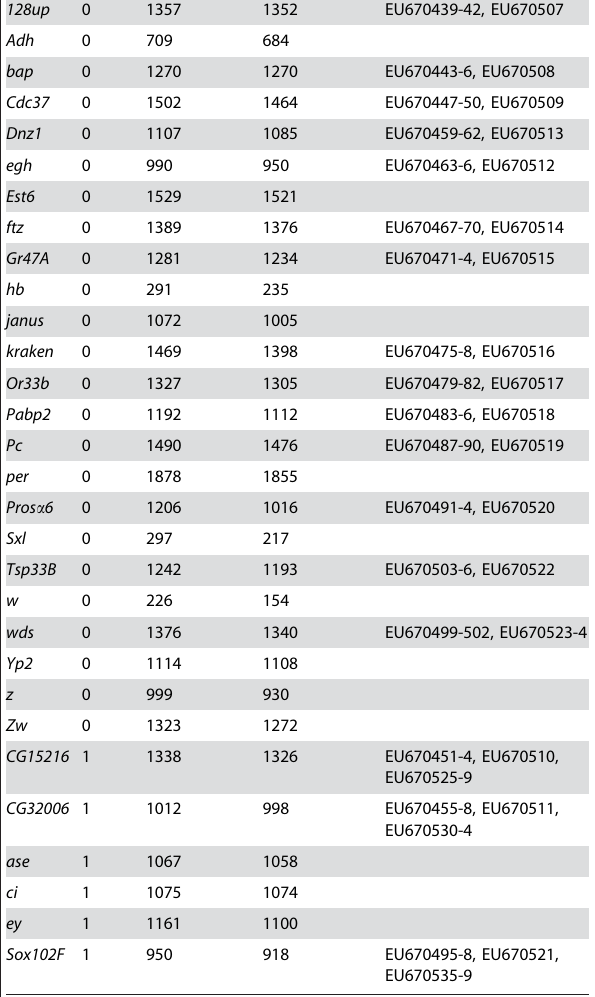
Table 1. Loci used in the study.